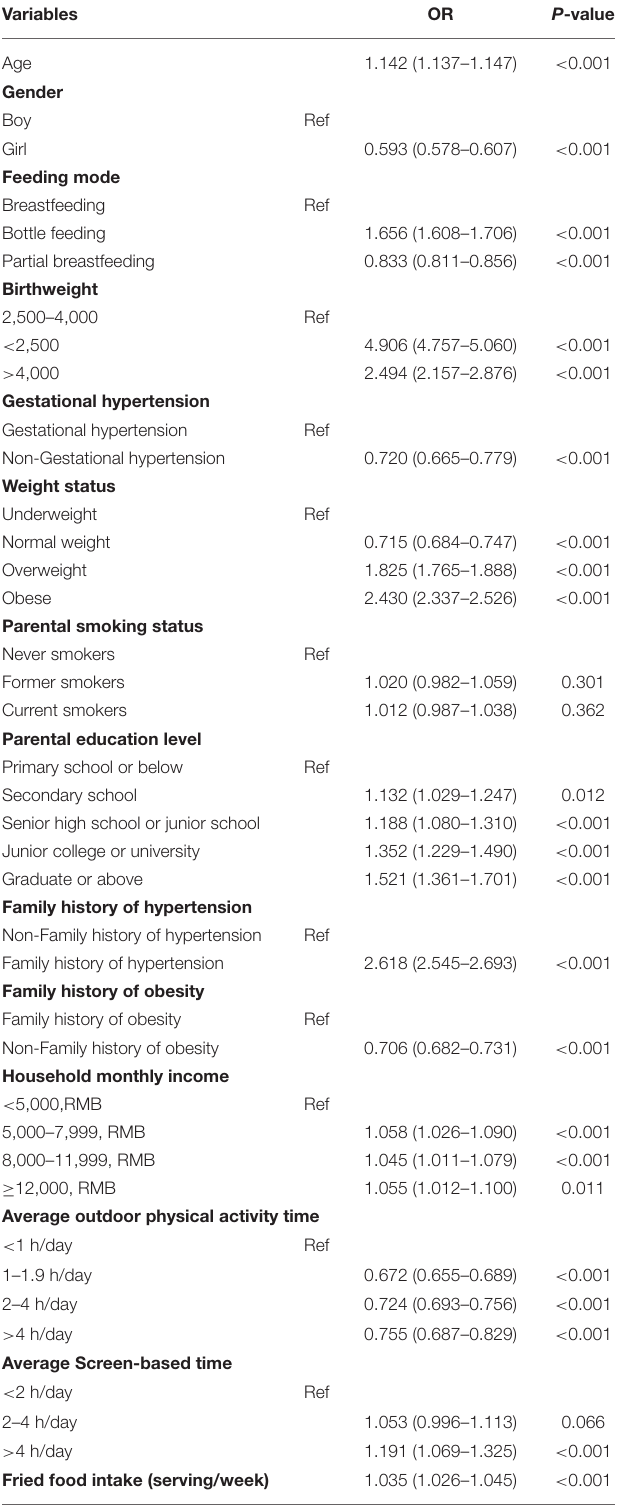
TABLE 2 | Multivariable Logistic regression analysis of variables predicting HBP in the development